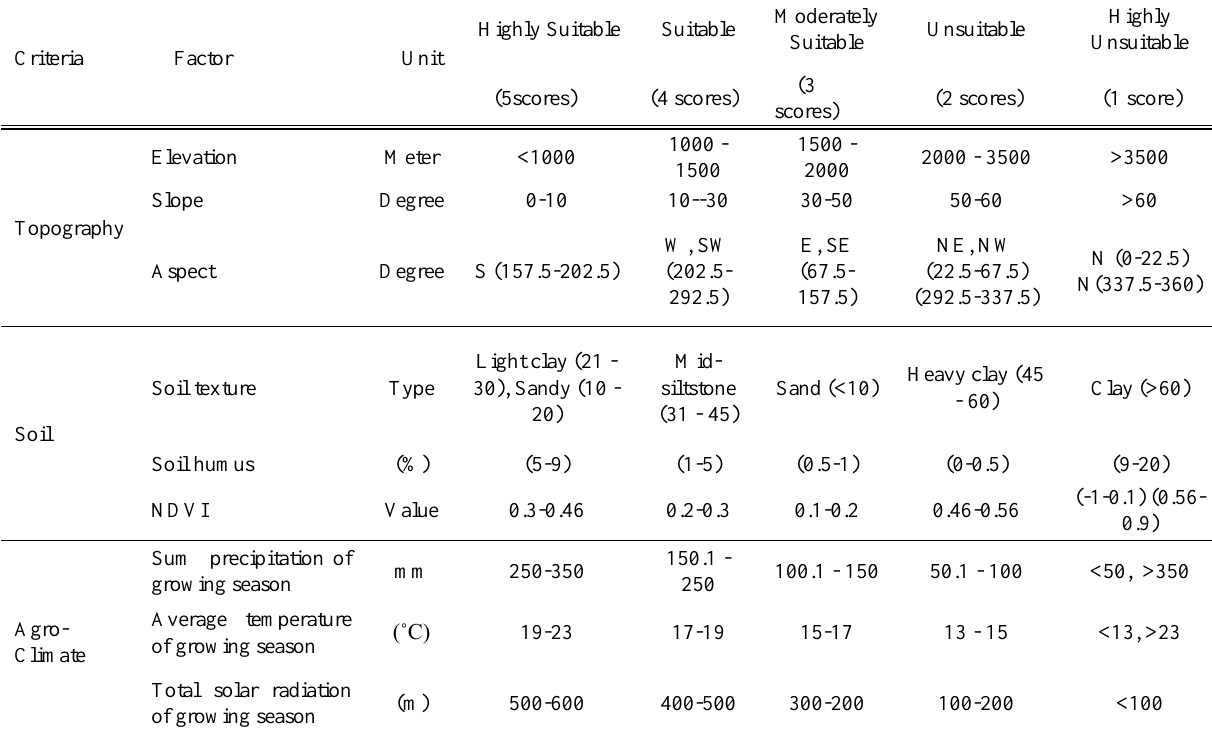
Table 1. Reclassification of the criteria influencing cropland suitability.